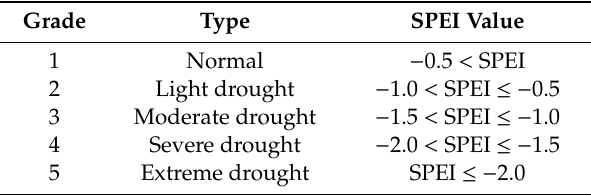
Table 1. Classification standard for drought based on the standardized precipitation evapotranspiration index